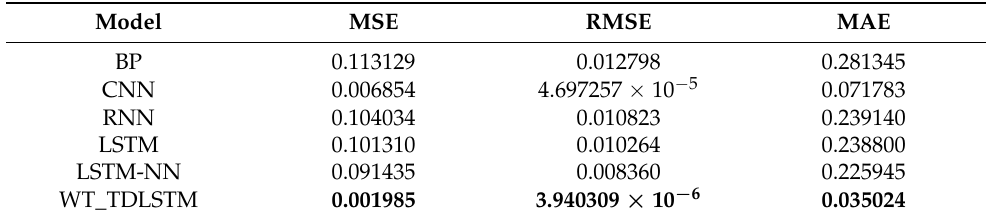
Table 3. Five randomized experimental average results of all the models on the residential monthly electricity price dataset.